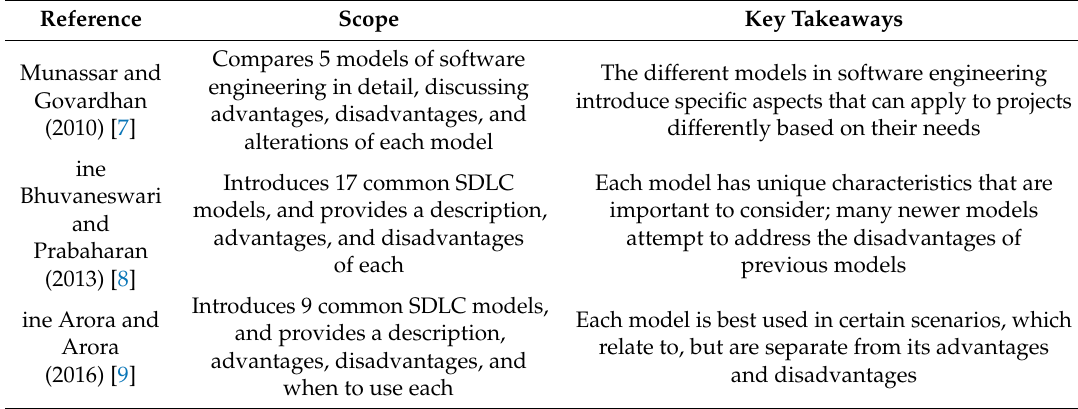
Table 3. Software development reviews.